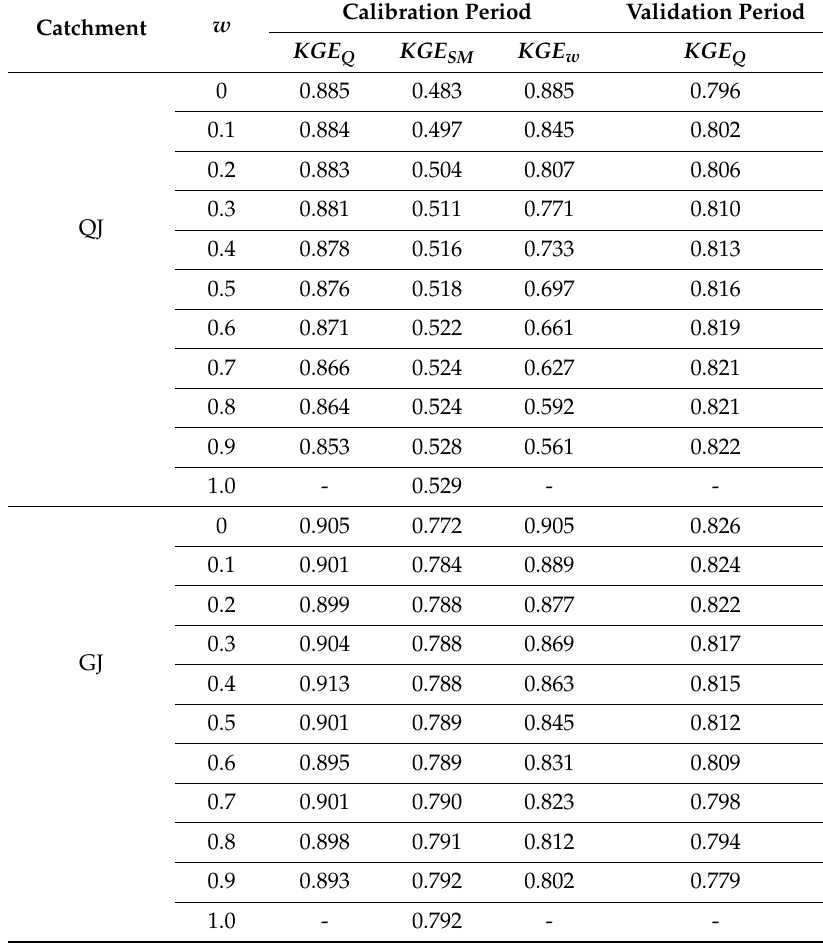
Table 2. Simulation performance of streamflow and soil moisture under 11 calibration schemes for QJ and GJ.